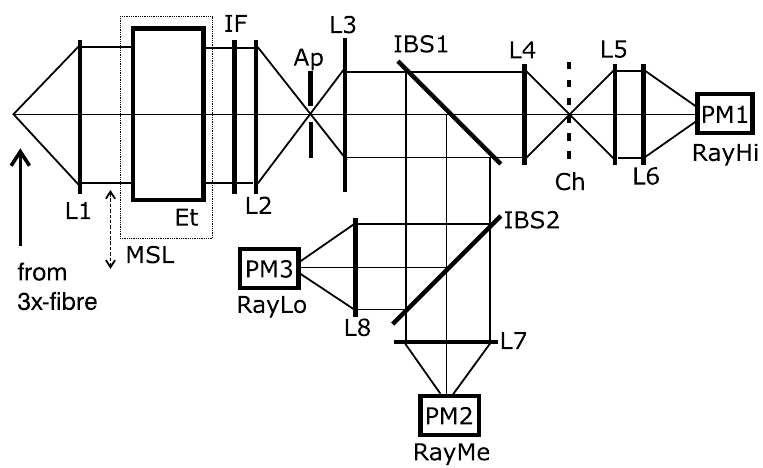
Table 3. Characteristics of the etalons in the 532-nm channels.